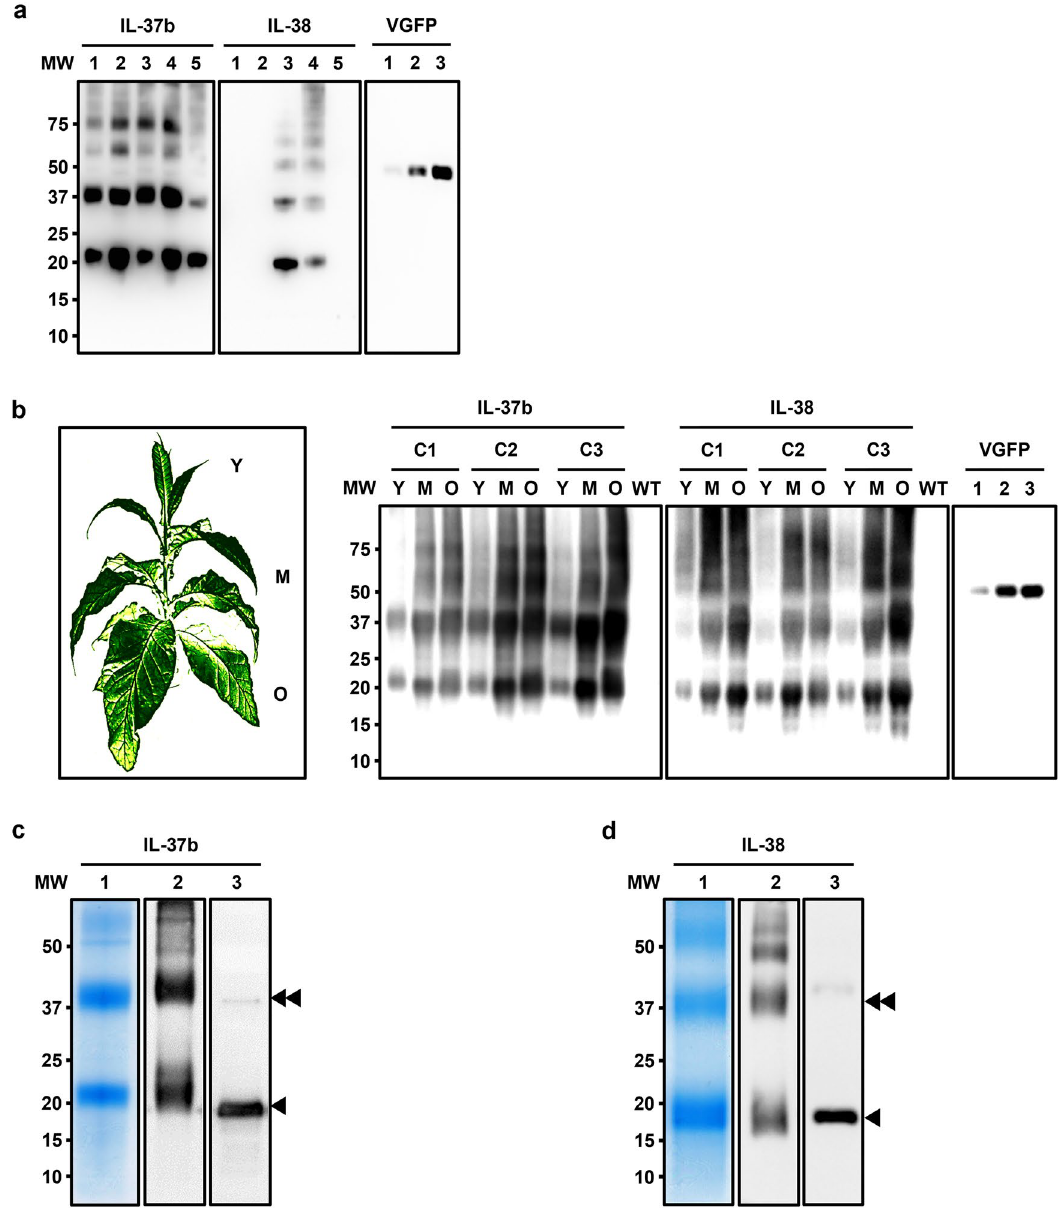
Figure 1. Expression and Purification of the Plantakines IL-37b and IL-38. ( a ) SDS-PAGE and Western blots of samples from crude leaf tissue extracts of the primary transplastomic clones generated for expression of plantakines IL-37b and IL-38 tagged with a HIS-tag at the C-terminus. Numbers 1–5 for each IL-37b and IL-38 represent extracts (~ 100 µg fresh leaf tissue) from different clones; clones 1, 2 and 5 for IL-38 show no expression. VGFP (EGEH 27 ) is a HIS-tagged GFP variant used as quantifiable control protein; lanes 1, 2 and 3 represent 12.5, 25 and 50 ng, respectively. All blots probed with the same anti-His tag antibody. ( b ) Left panel: Schematic representation of a greenhouse-grown bioreactor plant assessed to determine the spatial expression patterns of the cytokines by sampling young (Y), mature (M) and old (O) leaves; Right panel: Three clones (C1, C2, C3) for each bioreactor line expressing either IL-37b or IL-38 were sampled (~ 1 mg fresh leaf tissue in lane) and assessed with Western blots. Wild-type (WT) tobacco extracts were used as negative controls. VGFP was used as quantifiable control protein; lanes 1, 2 and 3 represent 12.5, 25 and 50 ng, respectively. ( c ) Lanes 1 and 2 both contain ~ 1 µg of the purified plantakine IL-37b, SDS-PAGE and stained (lane 1) or Western-blotted and probed with anti-IL-37 antibody (lane 2) along with 500 ng of bacteria-produced human recombinant IL-37b as a control (lane 3). ( d ) Lanes 1 and 2 both contain ~ 1 µg of the purified plantakine IL-38, SDS-PAGE and stained (lane 1) or Western-blotted and probed with anti-IL-38 antibody (lane 2) along with 500 ng of bacteria-produced human recombinant IL-38 as a control (lane 3). Molecular weight marker (MW) ladder is in kiloDaltons. Single black triangle arrows depict the monomers of the plantakines of the predicted molecular sizes (20.3 kDa and 18.3 kDa for IL-37b and IL-38, respectively), double arrows depict the dimers. Higher molecular weight multimeric structures are also detectable. Original blots/gels used for Figure 1 compilation are presented in Supplementary